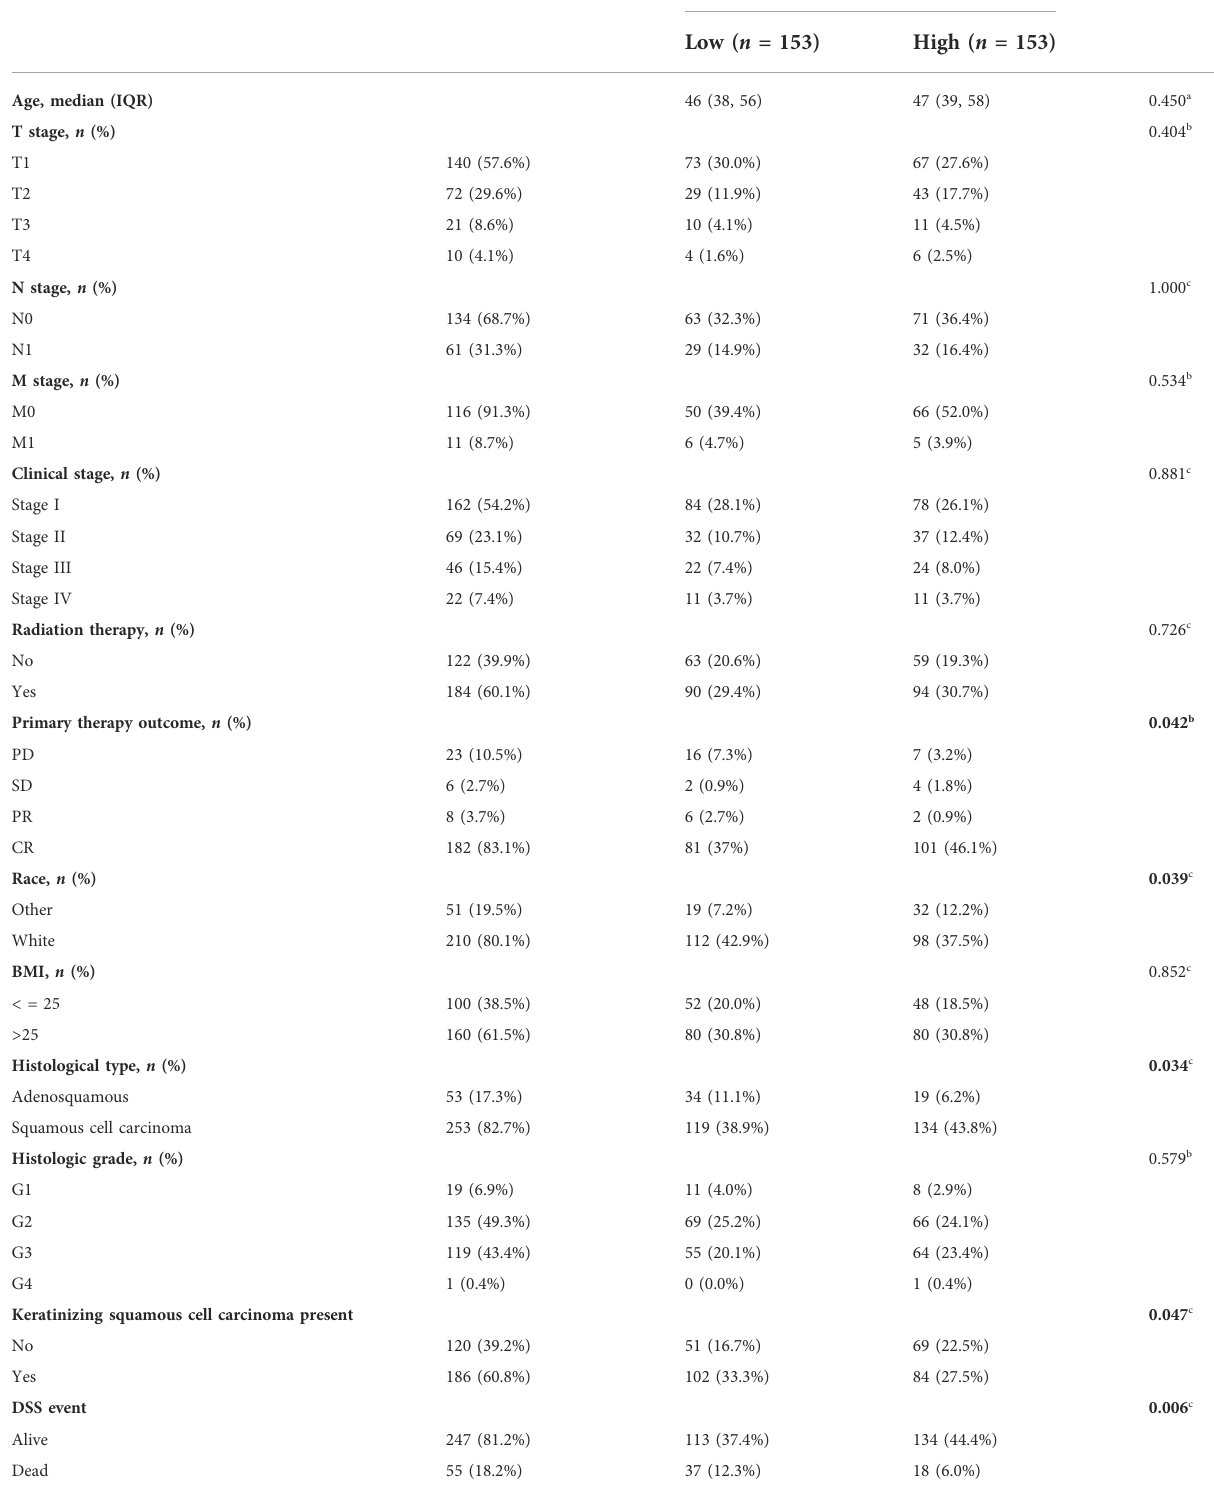
TABLE 1 Relationship between CD79B expression in cervical cancer and clinicopathological